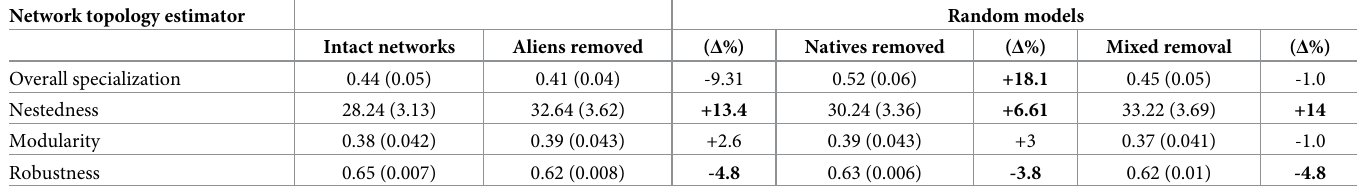
Table 4. Mean ( ± SE) plant-floral visitor interaction network metrics and average rate of change ( Δ %, according to Hedge´s size effects) under different extinction scenarios in nine sites along the north coast of Yucatan, Mexico. Significant differences in the Δ % between “intact network” vs “aliens removed”; “intact networks” vs. “native removed”; and “intact networks” vs. “random removal” scenarios are shown in bold (p <